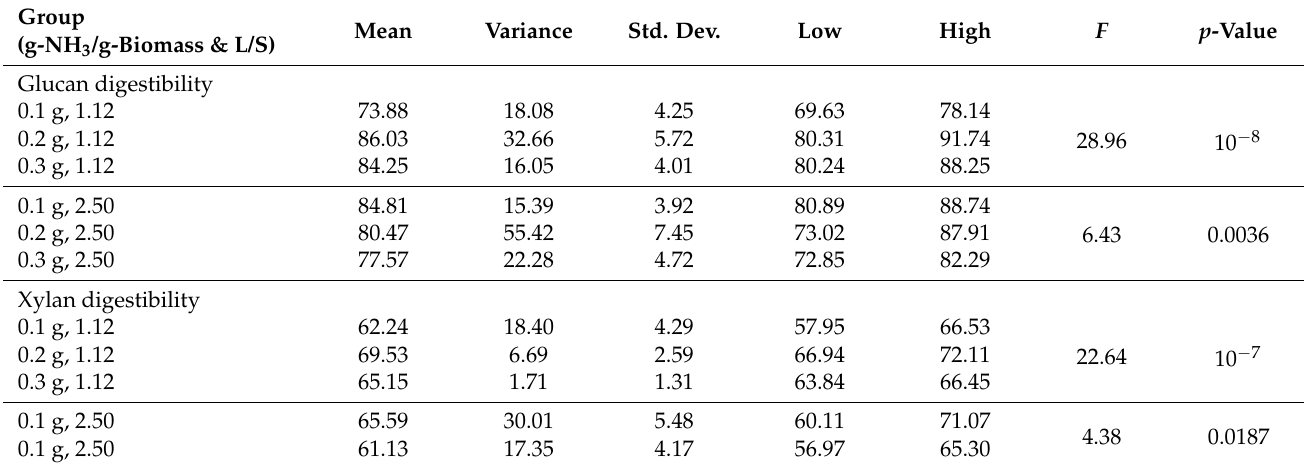
Table 3. ANOVA results of glucan and xylan digestibility tests at different ammonia concentrations.